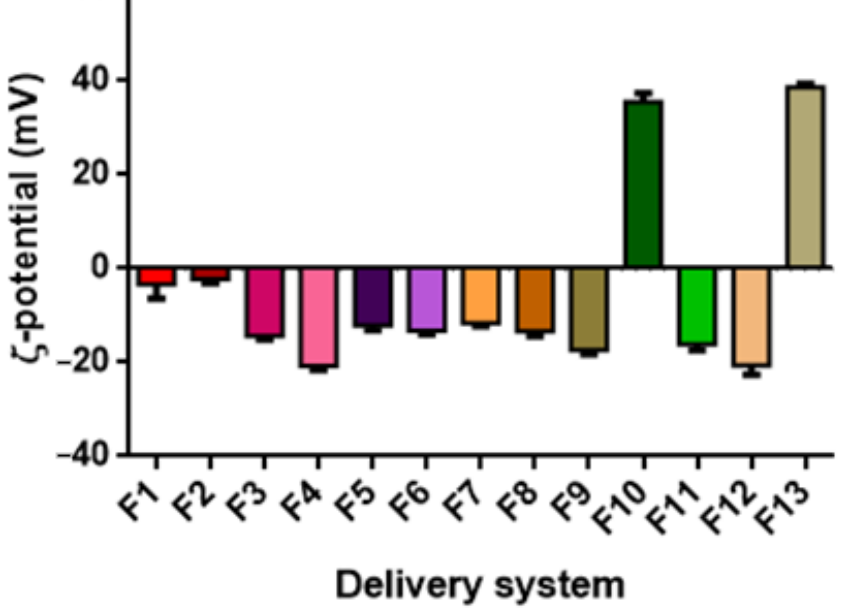
Figure 4. Hydrodynamic diameter (d H ) and polydispersity index (PDI) of TA EO nanoemulsions